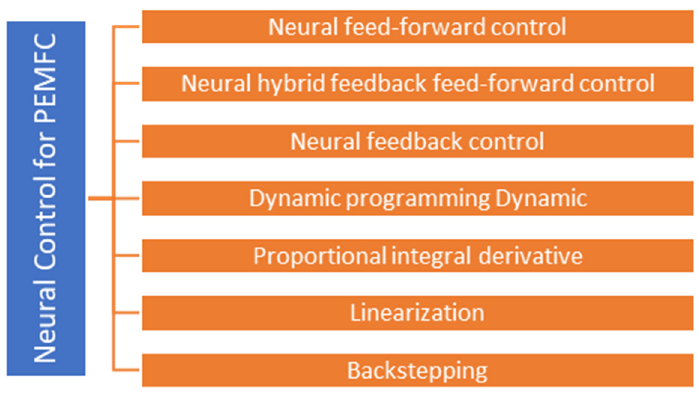
Figure 2. Neural control techniques applied to PEM fuel cells.